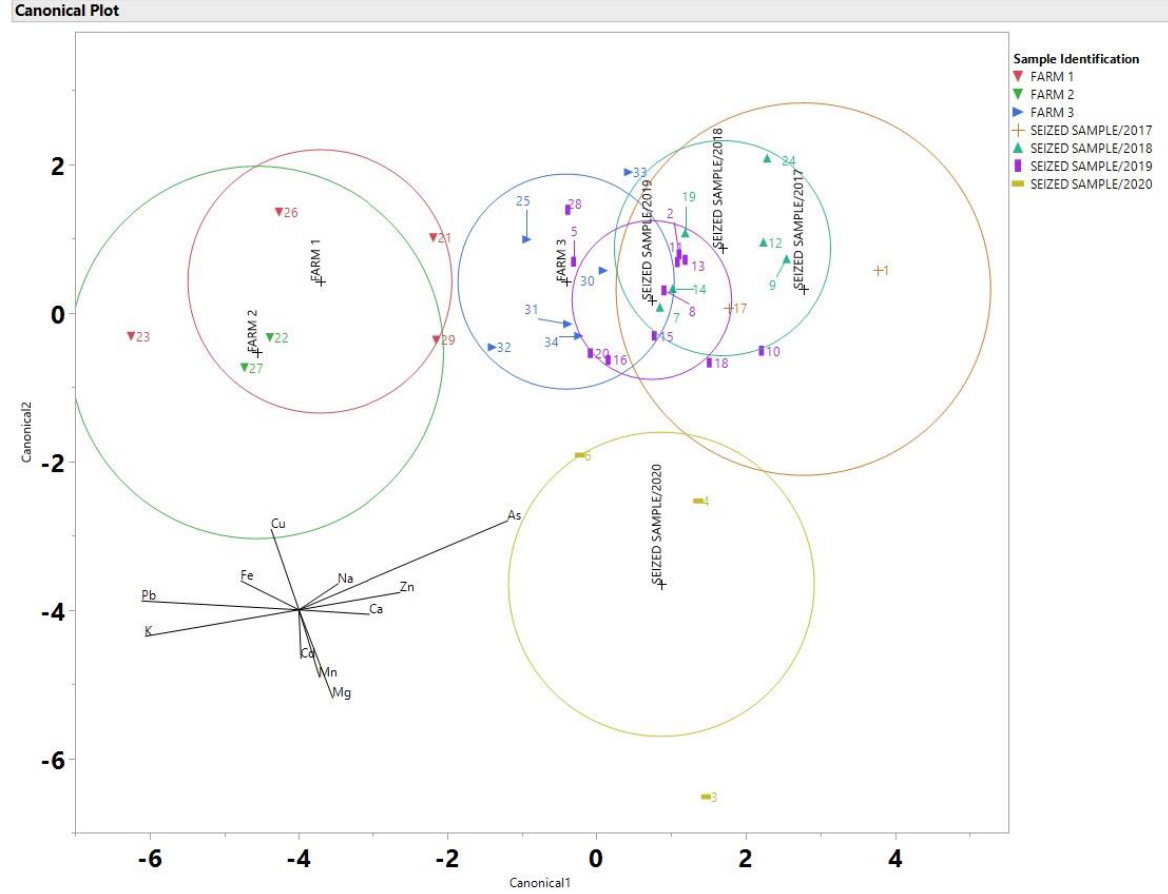
Figure 5. Linear Discriminant (DA) canonical plot using data for 11 elements determined by ICP- MS of the cannabis samples (sample labeling can be found in Table S1). of the cannabis samples (sample labeling can be found in Table